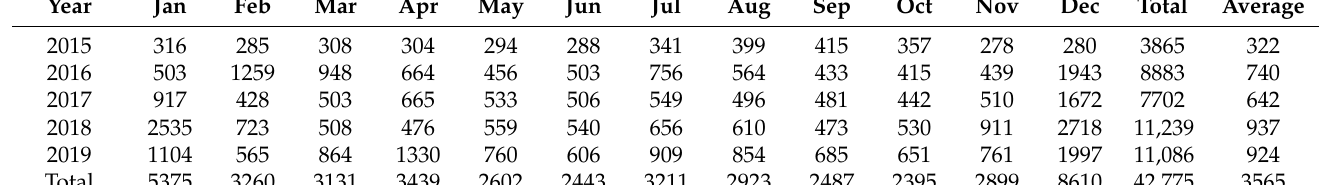
Table 3. Monthly numbers of newly diagnosed encephalitis patients in Korea.